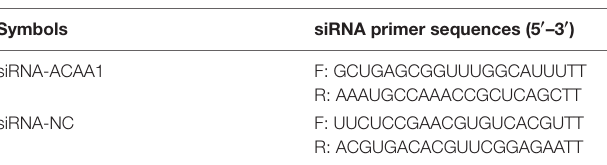
TABLE 1 | siRNA sequences. Symbols